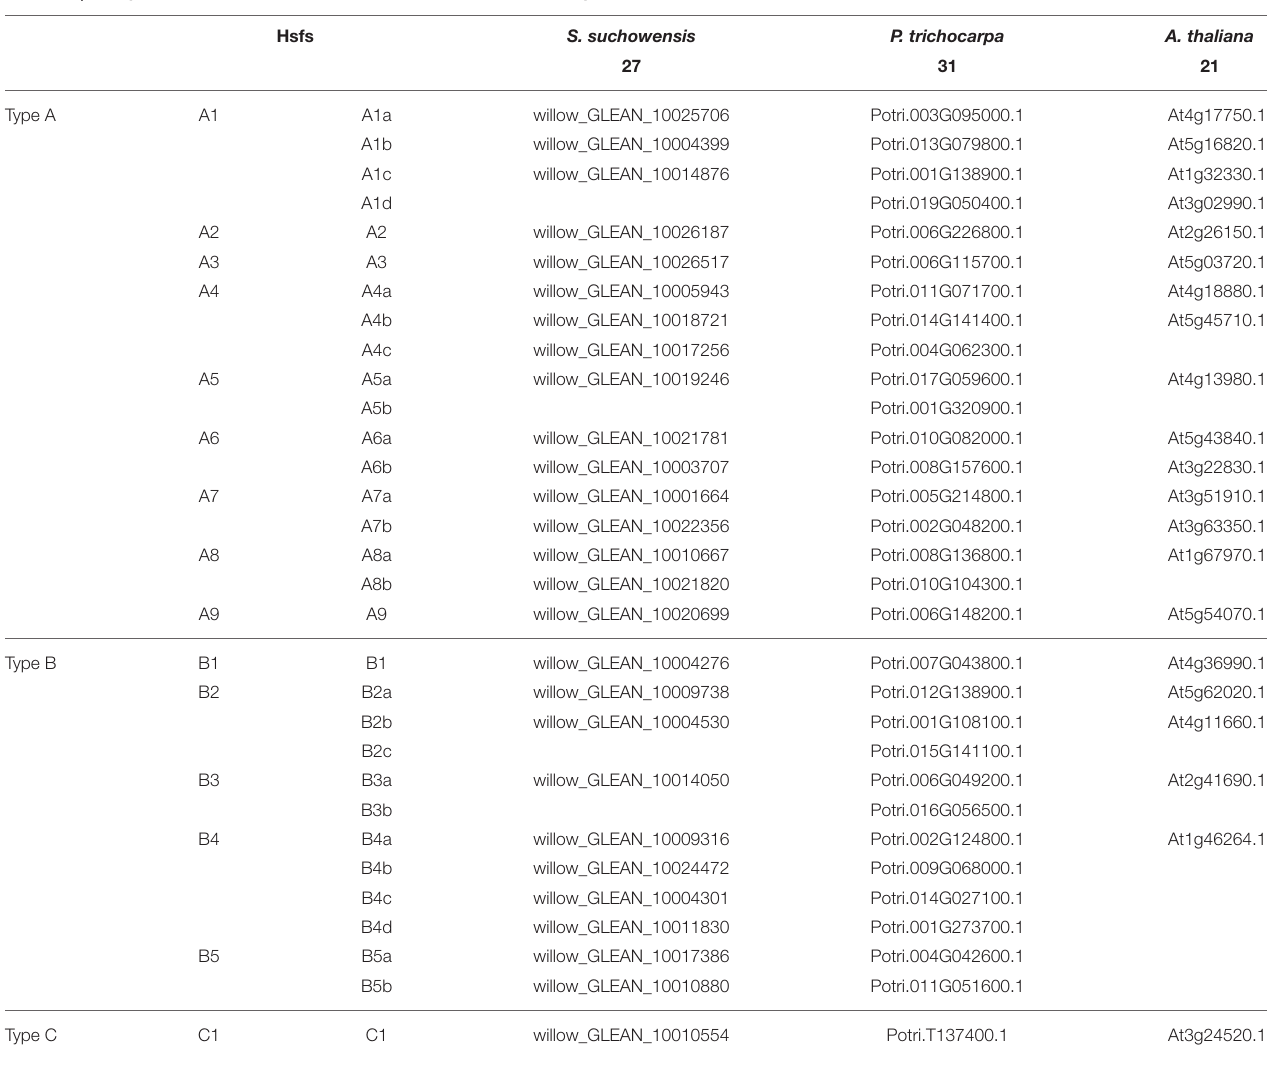
TABLE 2 | Comparison of Hsf members in S. suchowensis , P. trichocarpa , and A. thaliana .